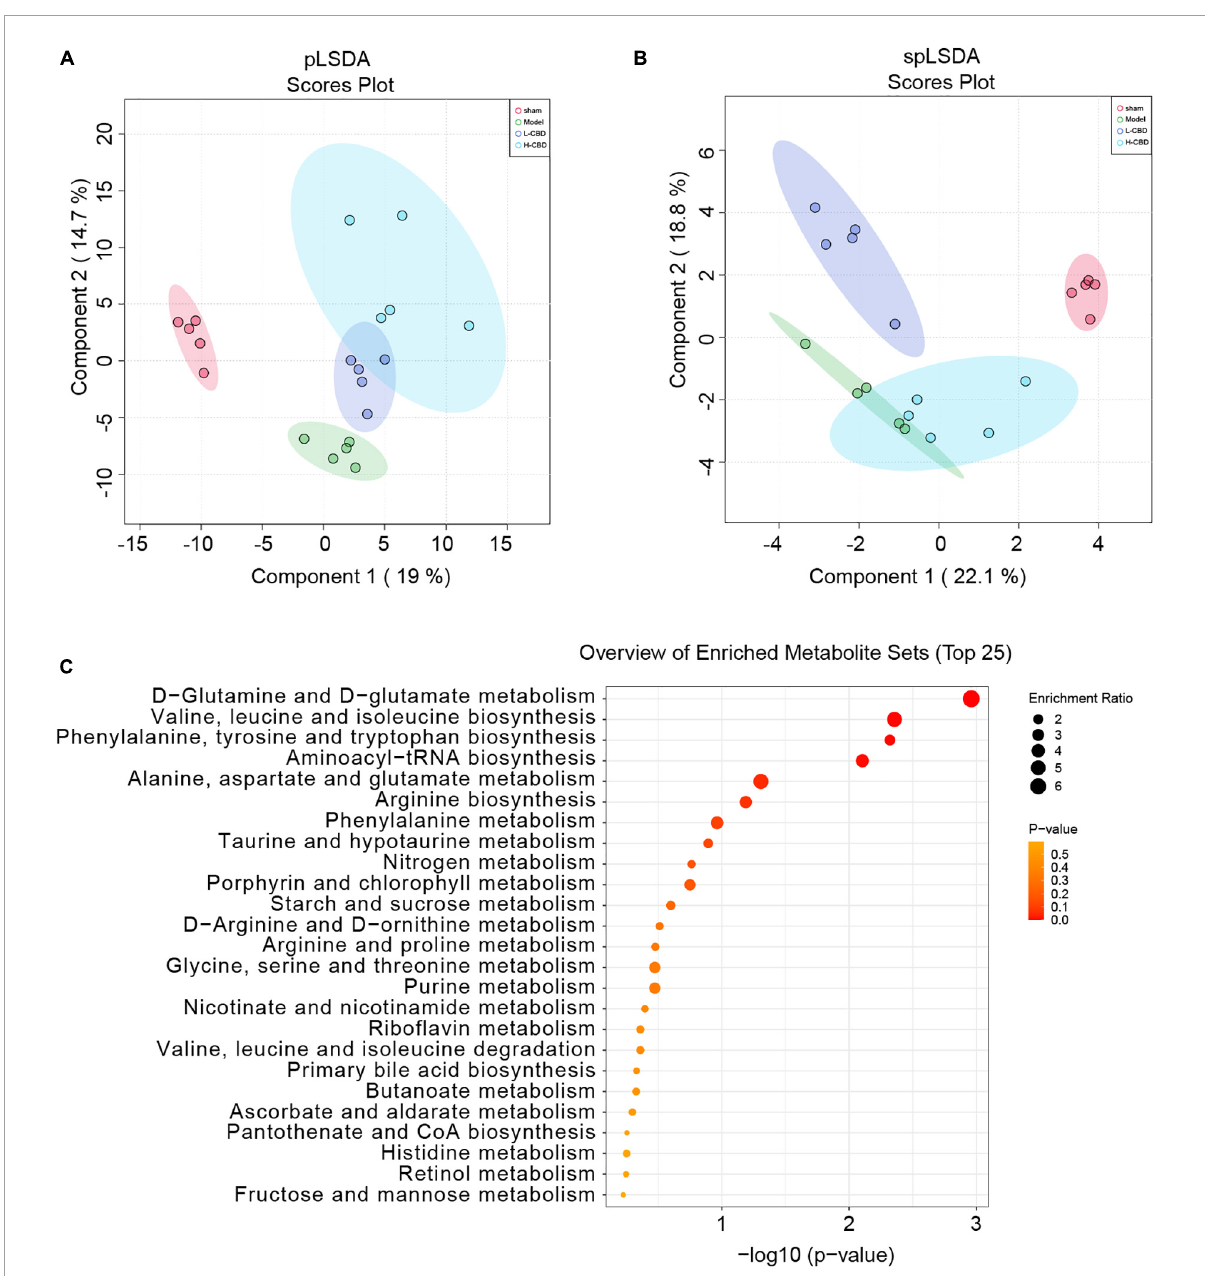
FIGURE8 Effects of cannabidiol (CBD) on fecal metabolism in epileptic rats. (A) partial least squares discriminant analysis (pLSDA) analysis. (B) sparse partial least squares discriminant analysis (spLSDA) analysis. (C) Enrichment of the differential metabolic pathways. A color change from yellow to red represents the lower of the P